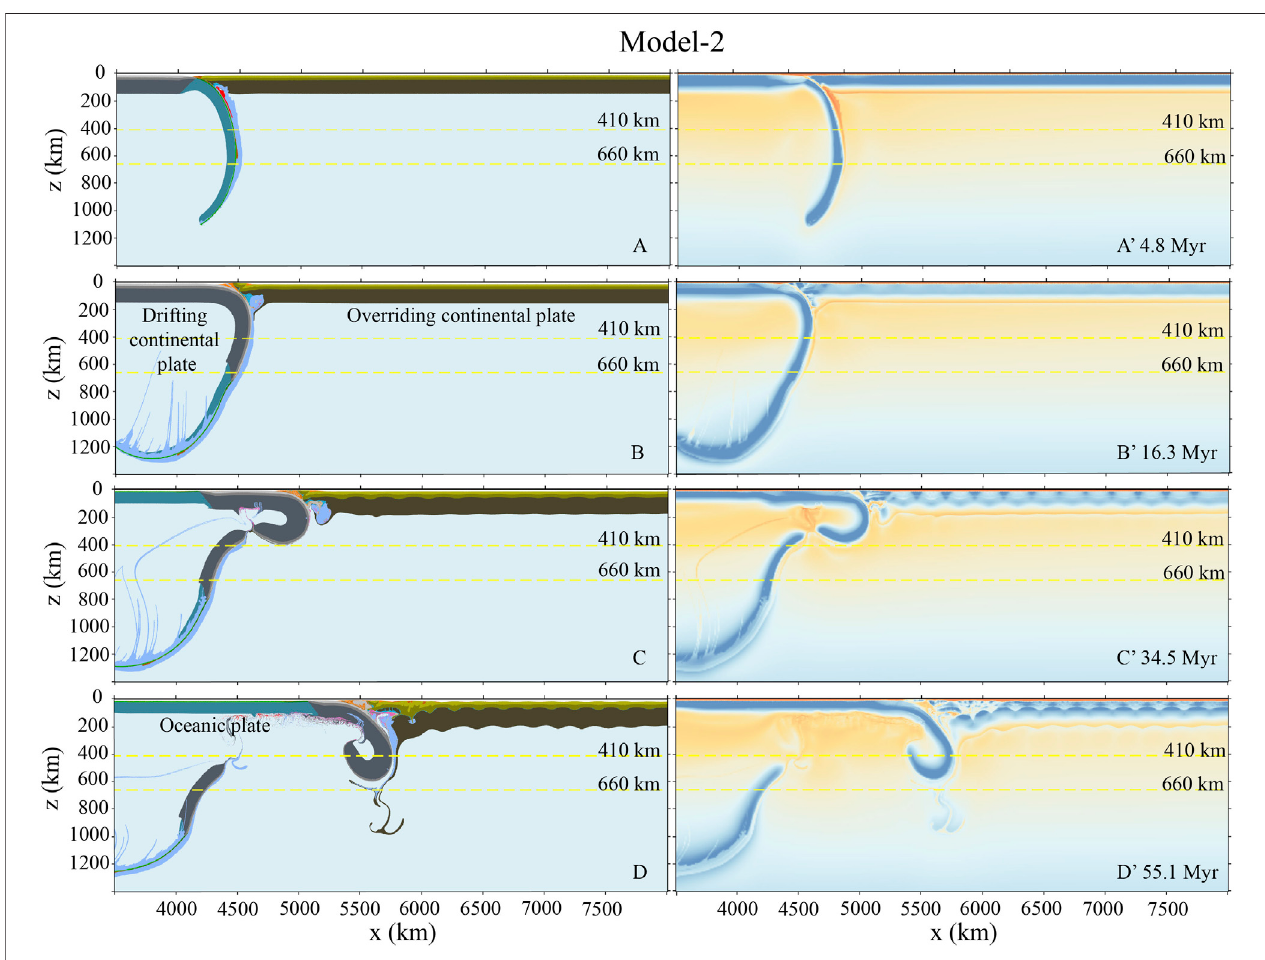
FIGURE 4 | Model-2 evolution with a decreased and uniform plastic friction coef fi cient of the overriding lithospheric mantle of λ · sin ( φ ) (cid:2) 0.1 ( Supplementary Table S2 and Supplementary Equation S11 in the supporting information). All the other parameters are identical to Model-1 ( Figure 3 ). (A – D) The composition fi eld evolution with the corresponding colorbar is shown in Figure 2A . (A ’ – D ’ ) The effective viscosity evolution with the corresponding colorbar is shown in Figure 2B .